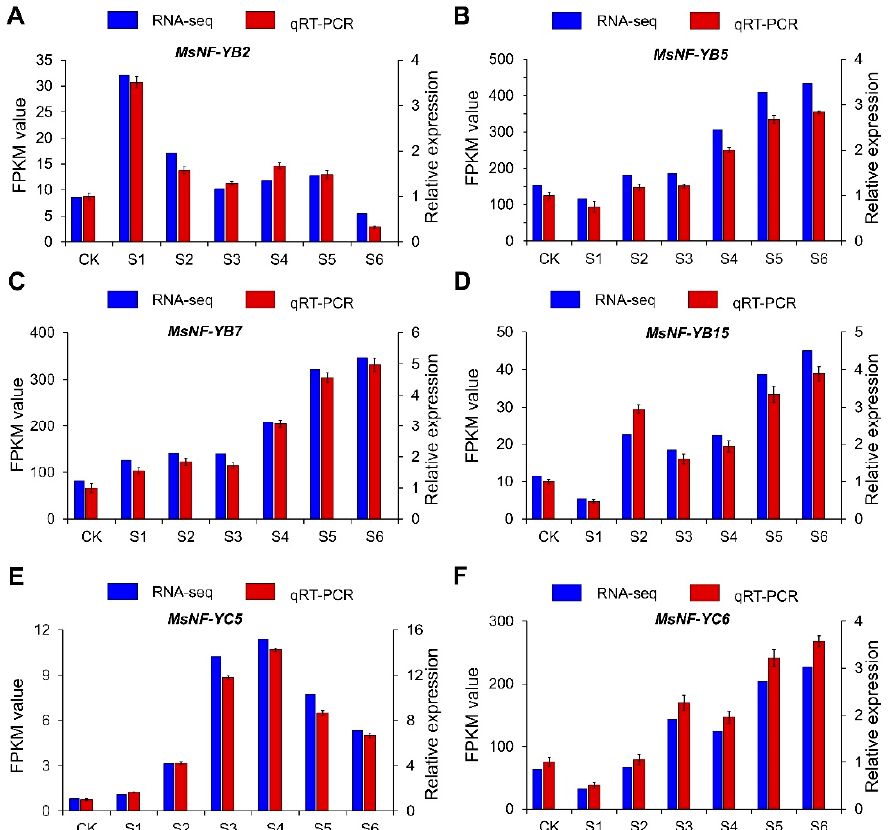
Figure 11. qRT-PCR analysis for genes related salt stress. ( A ) MsNF-YB2 , ( B ) MsNF-YB5 , ( C ) MsNF- YB7 , ( D ) MsNF-YB15 , ( E ) MsNF-YC5 , and ( F ) MsNF-YC6 .